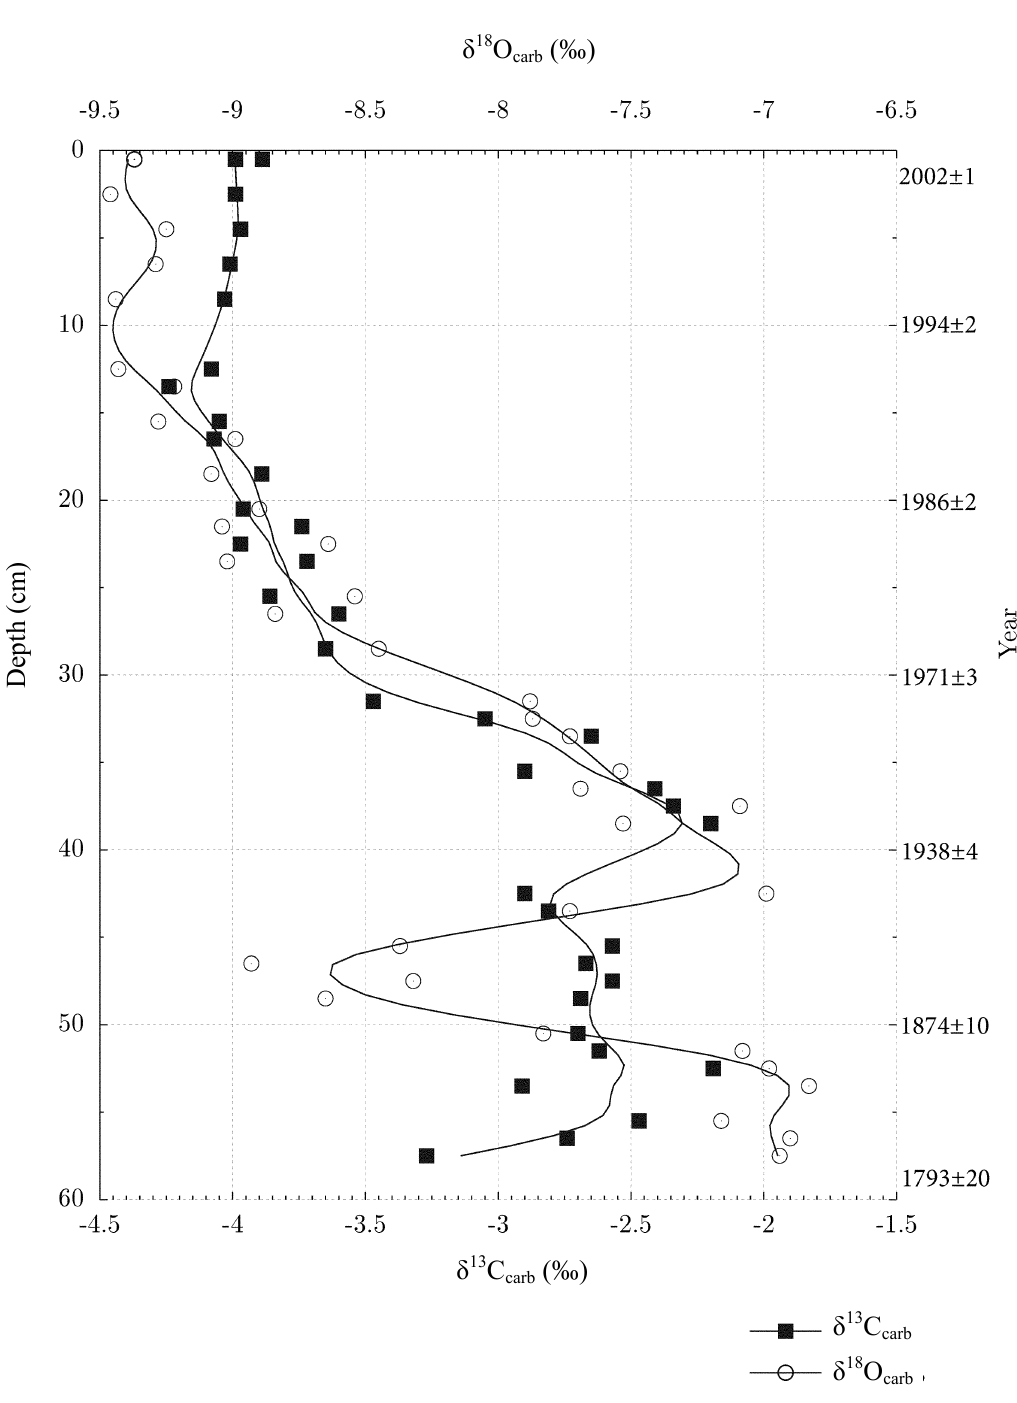
Fig. 6. Variation in  13 C and  18 O values in carbonate fraction of the sediment